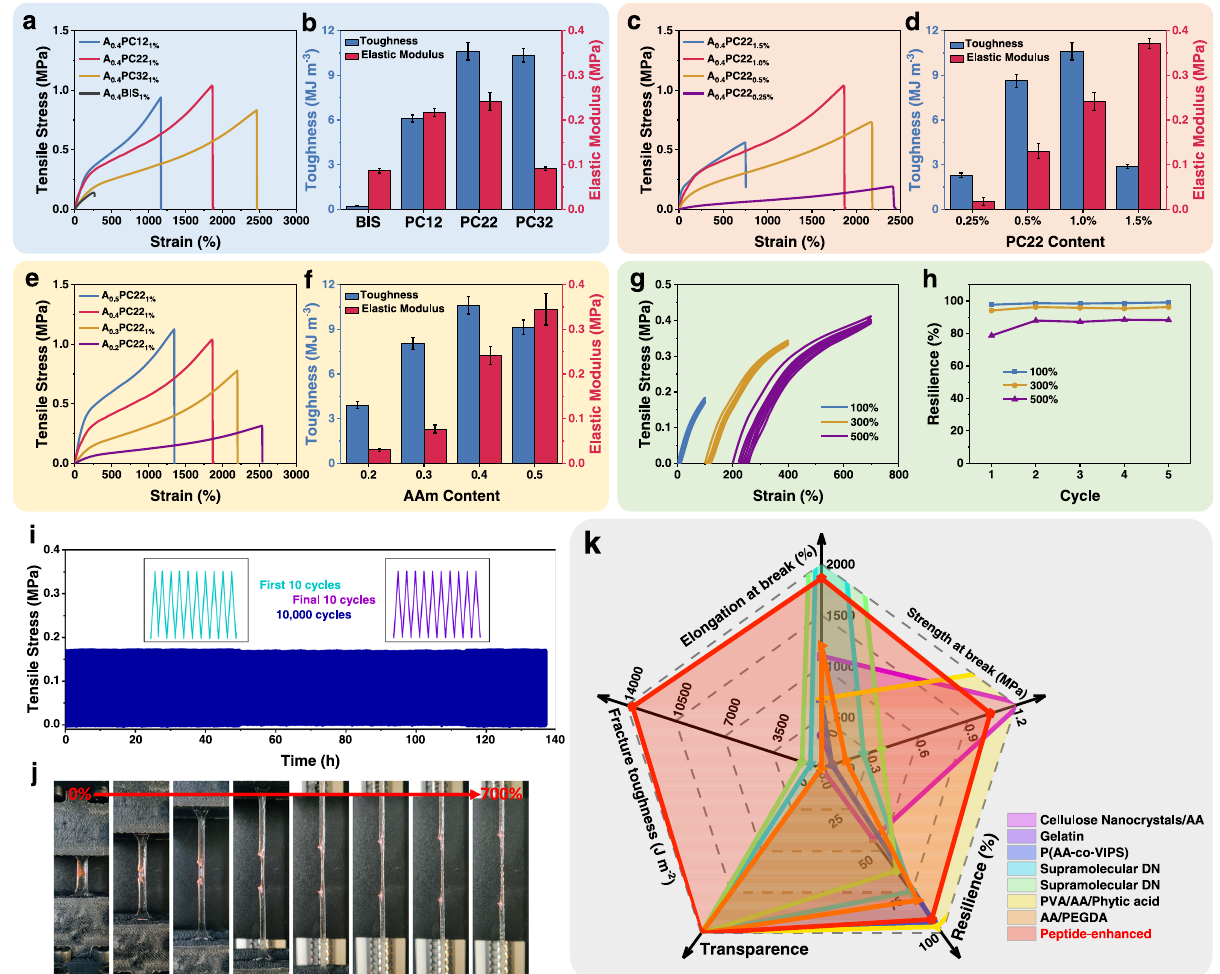
Fig. 3 | Tensile mechanical properties of the eutectogels with [ChCl][EG] as solvent. a , b Tensile stress-strain curves ( a ) and mechanical properties ( b ) of gels crosslinked with different crosslinkers. c , d Tensile stress-strain curves ( c ) and mechanical properties ( d ) of gels crosslinked with various amount of PC22. e , f Tensile stress-strain curves ( e ) and mechanical properties ( f ) of the PC22- crosslinked gelswith various contents ofAAm. g Stress-straincurvesof A 0.4 PC22 1% gel during 5 consecutive loading-unloading cycles at a maximum strain of 100%, 300%, and 500%. The curves at a maximum strain of 300% and 500% were shifted